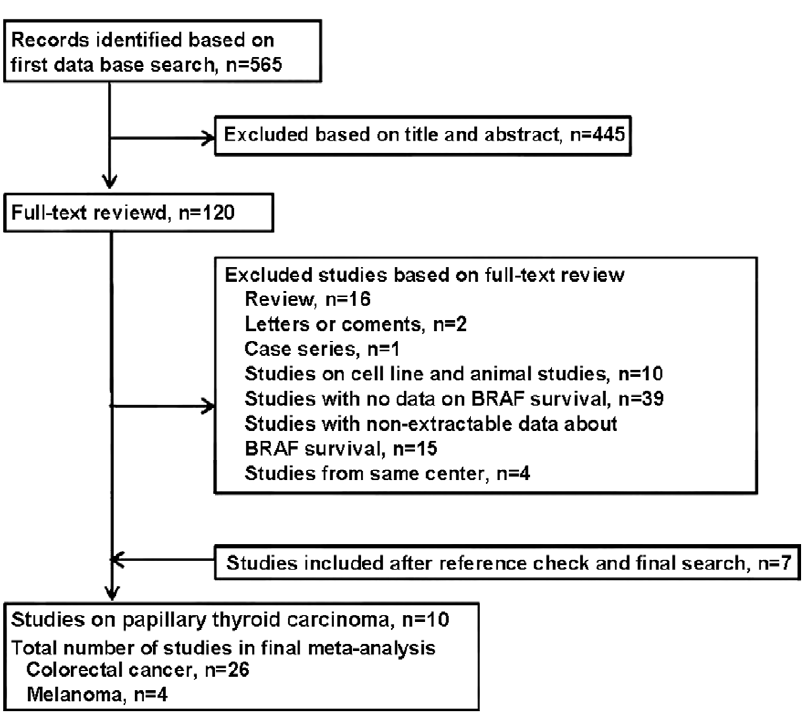
Figure 1. Flow diagram demonstrates the study selection process.